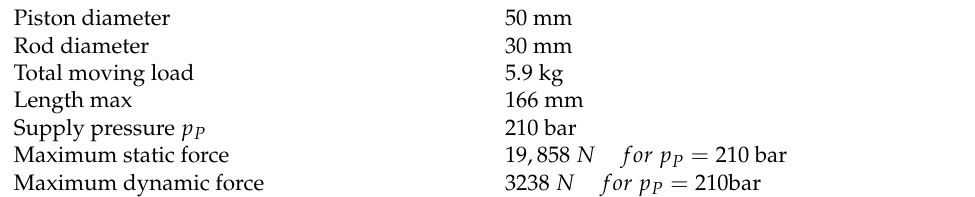
Table A1. Hydraulic actuator